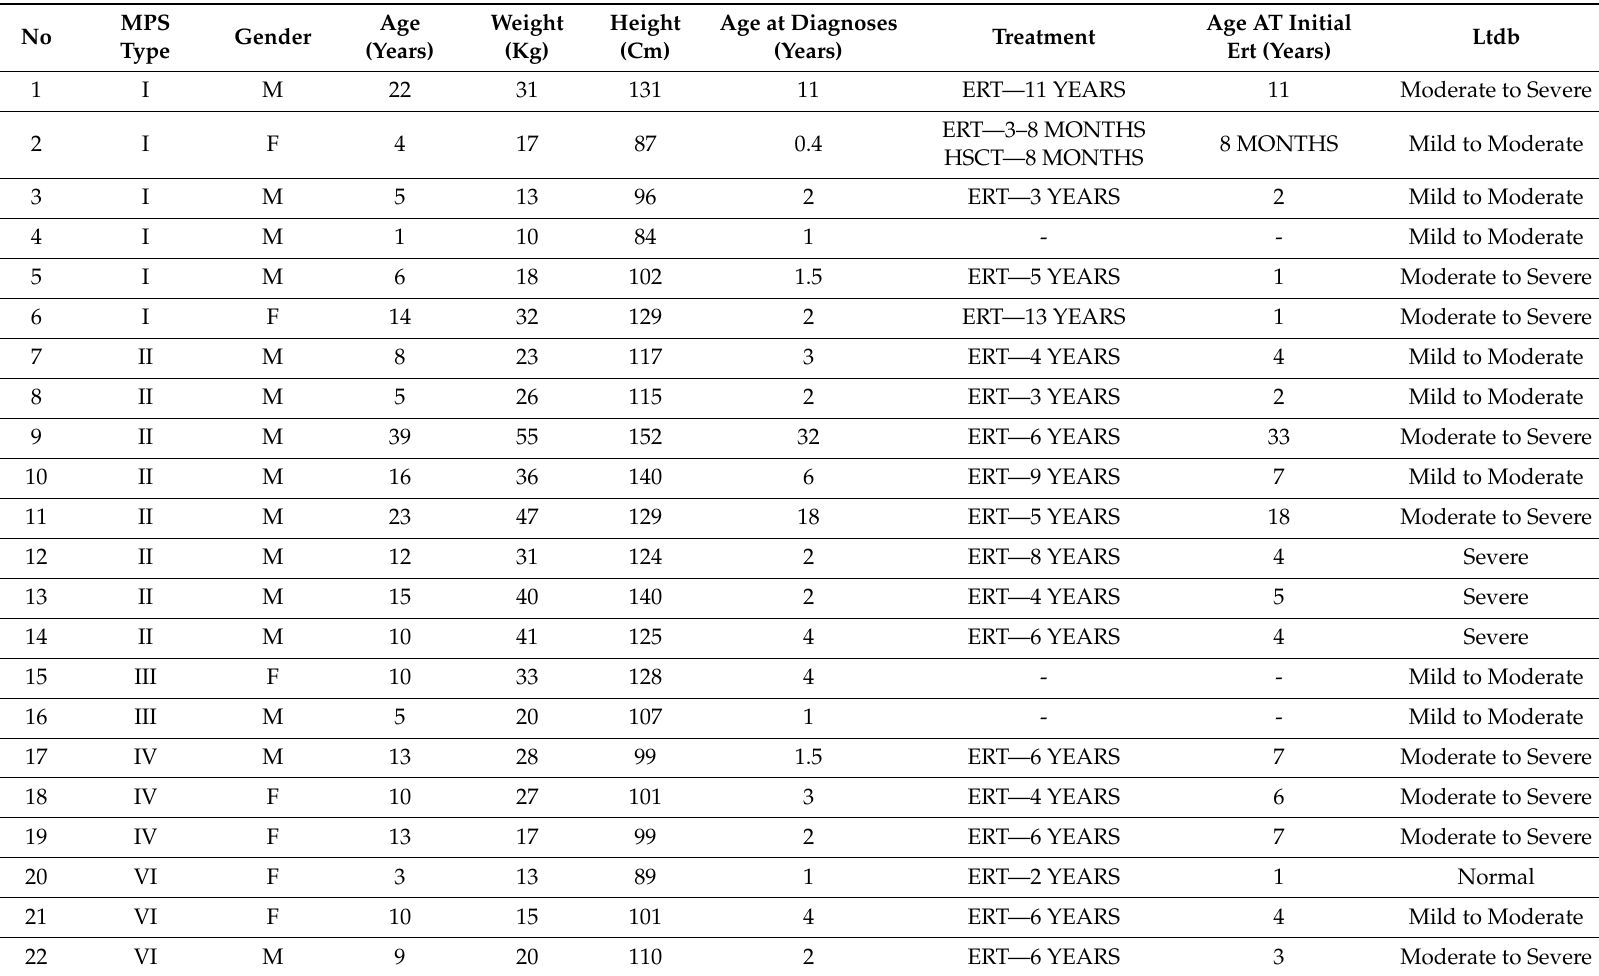
Table 1. Clinical characteristics of 30 MPS